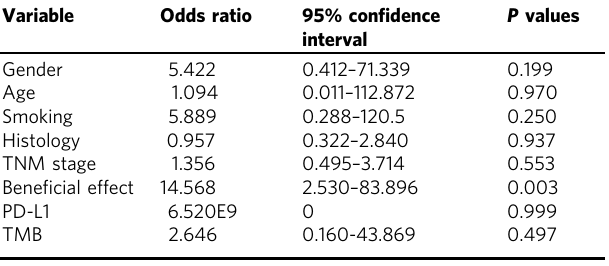
Table 3 AhR-high and patients ’ clinical characteristics